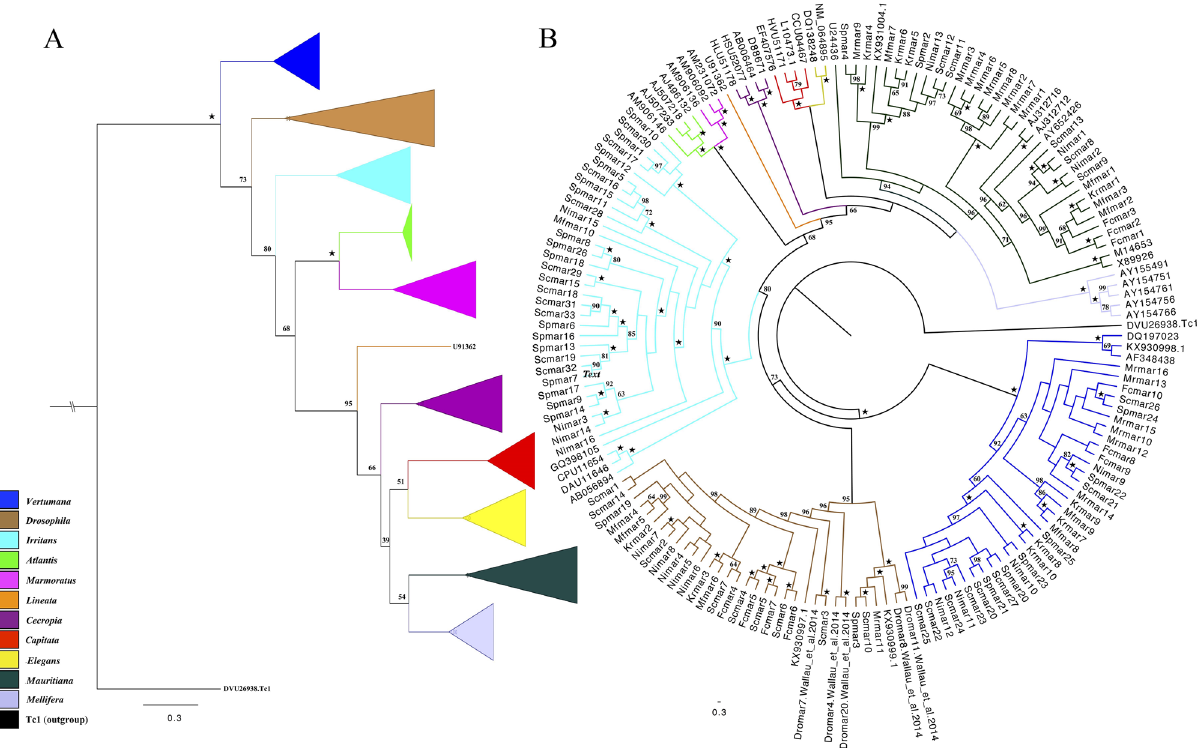
Figure 1. ML phylogenetic tree of Mariner lineages constructed with RAxML using GTRGAMMA substitution model. Clade colours denote the different subfamilies of MLEs. (A) Different subfamilies of the Mariner family with element from Tc1 family as outgroup. (B) 165 Mariner -like elements, i.e., 44 from GenBank and 121 from seven species of Rhus gall aphids. The branch end showed the NCBI accession numbers of the MLEs downloaded from the database and the names of MLEs detected in this study. *Indicates 100% support by all bootstrap replicates.